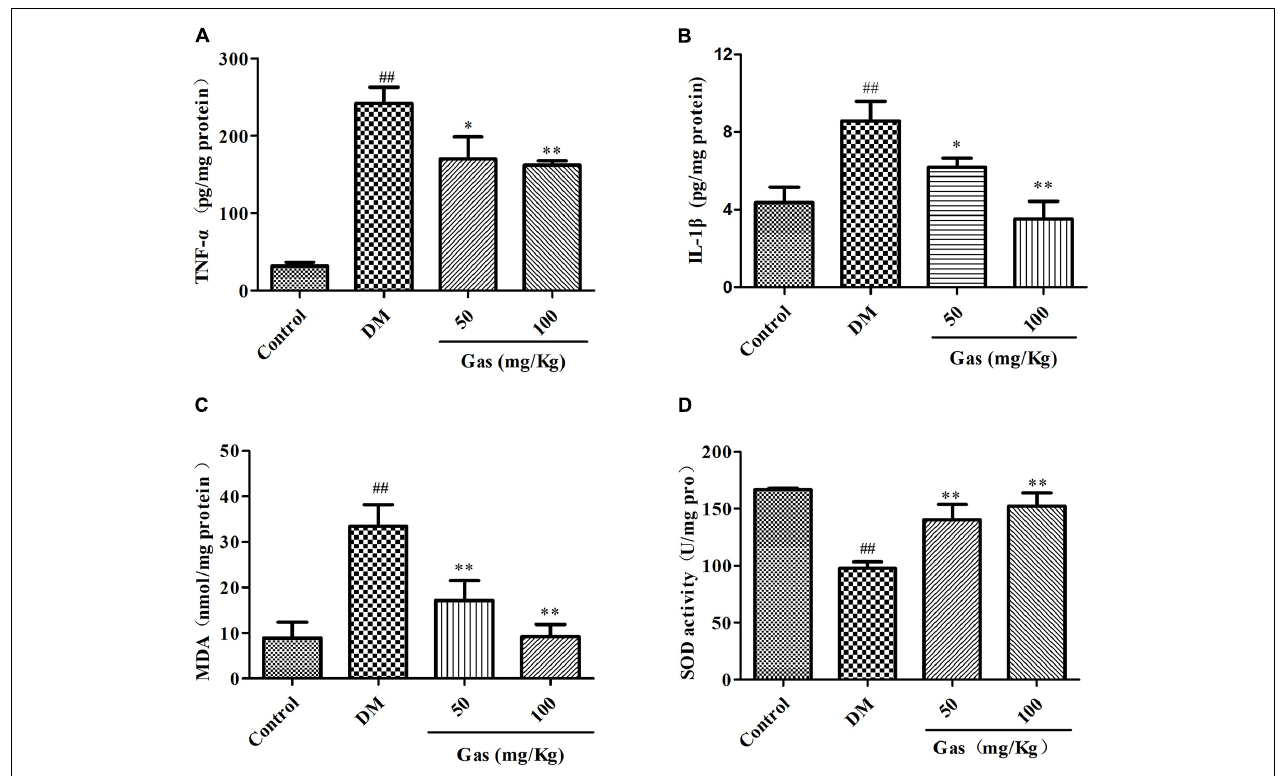
FIGURE 7 | Gas decreased the contents of TNF- α , IL-1 β , MDA and increased SOD contents in the hippocampus of DM rats. (A) Levels of TNF- α in the hippocampus of every groups after 5 weeks of treatment. (B) Levels of IL-1 β in the hippocampus of every groups after 5 weeks of treatment. (C) Levels of MDA in the hippocampus of every groups after 5 weeks of treatment. (D) Levels of SOD in the hippocampus of every groups after 5 weeks of treatment. Values are represented as means ± SD for 10 rats in each group. ## P < 0.01, compared with the control group. ∗ P < 0.05, ∗∗ P < 0.01, compared with the DM group.